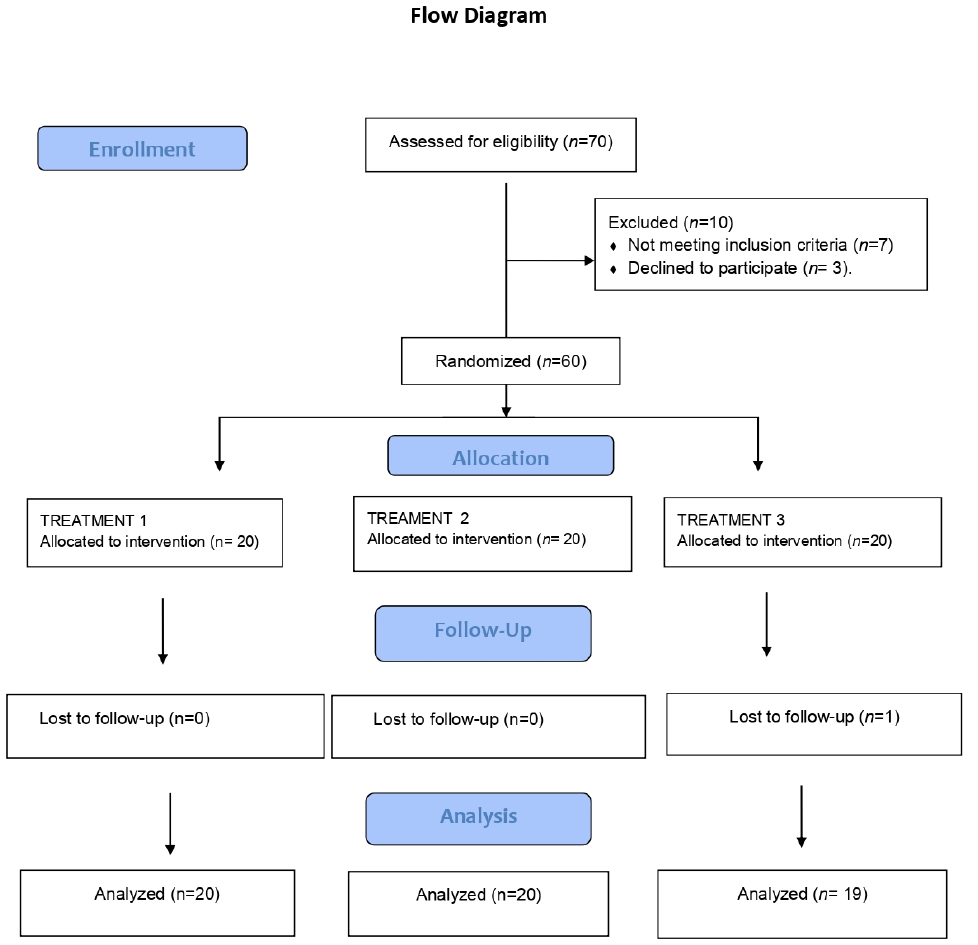
Figure 1. Flow Figure 1. Flow diagram.